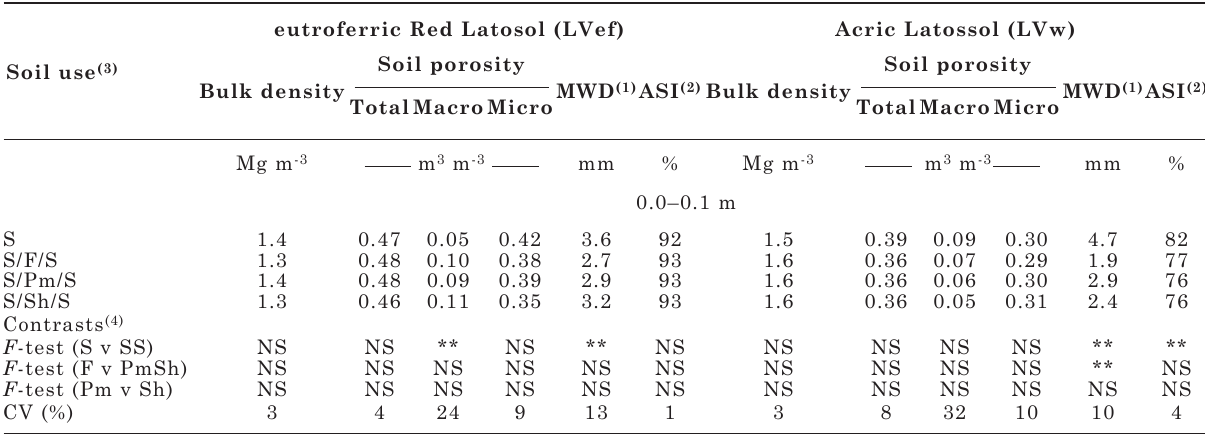
table 8. Soil physical properties at different soil layer at the end of the experiment, and significance of the contrasts